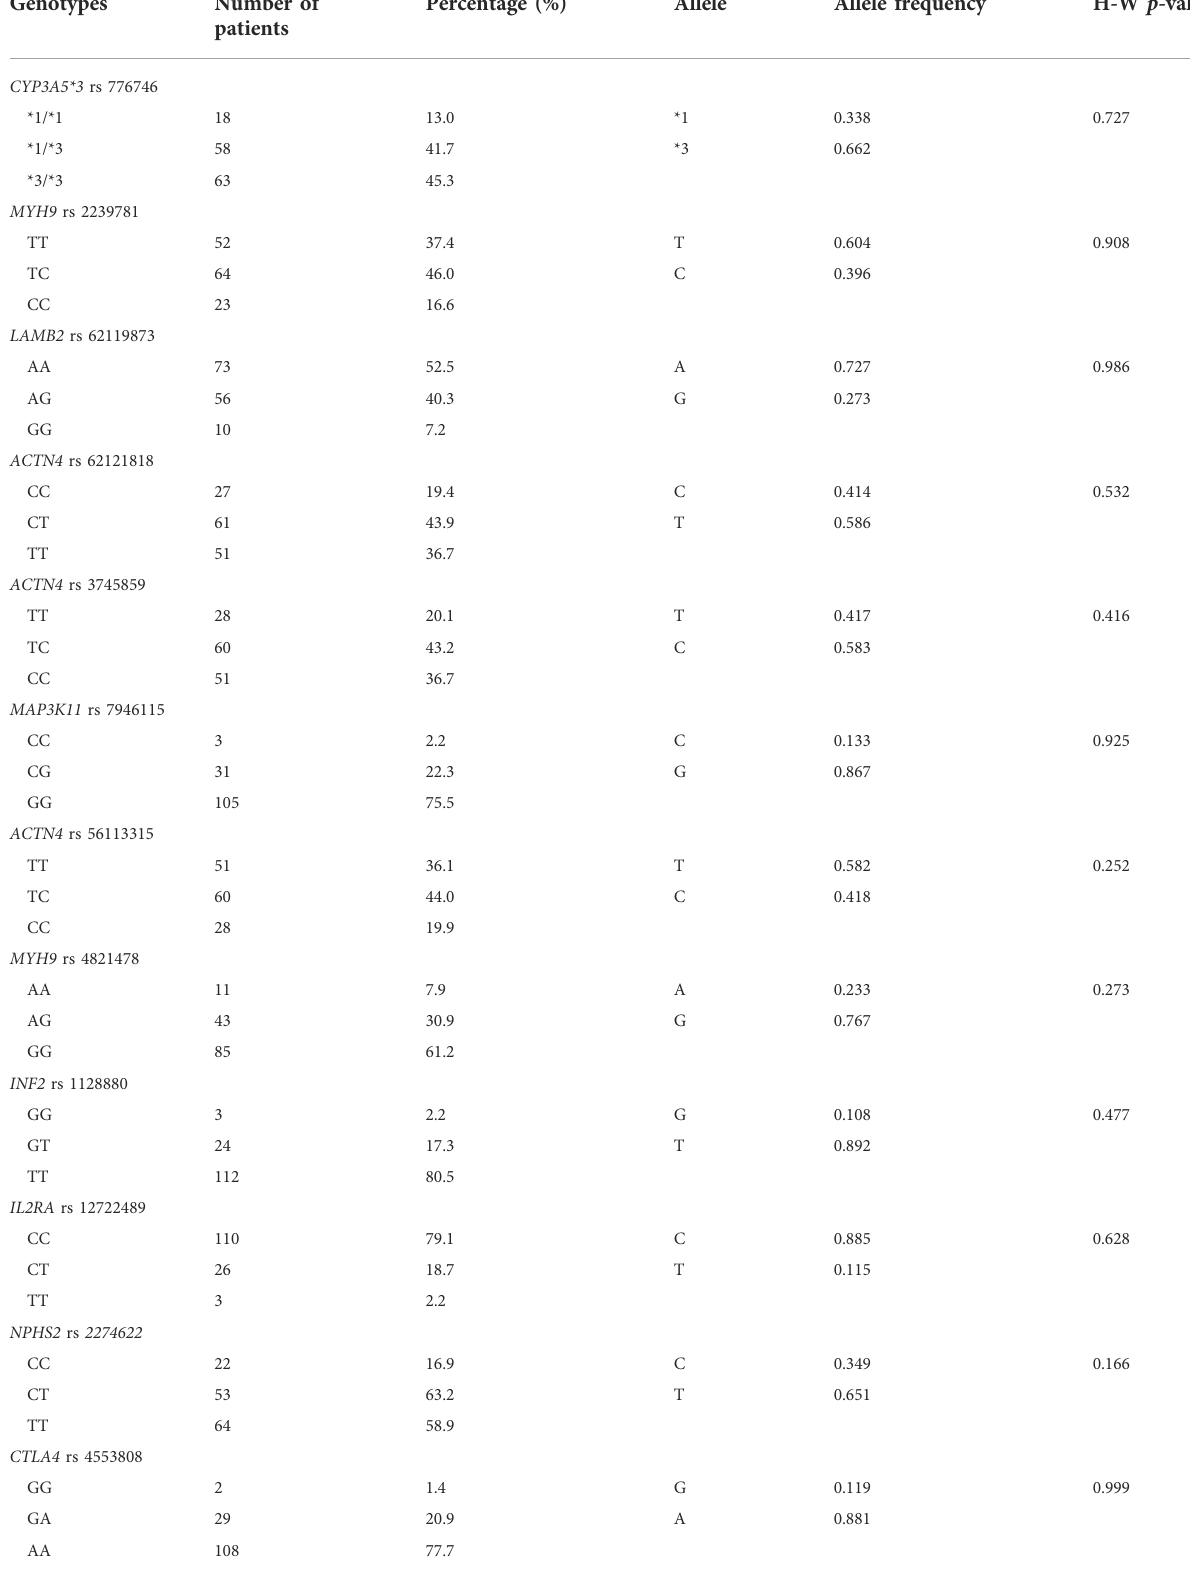
TABLE 2 Genotypes and allele frequencies of